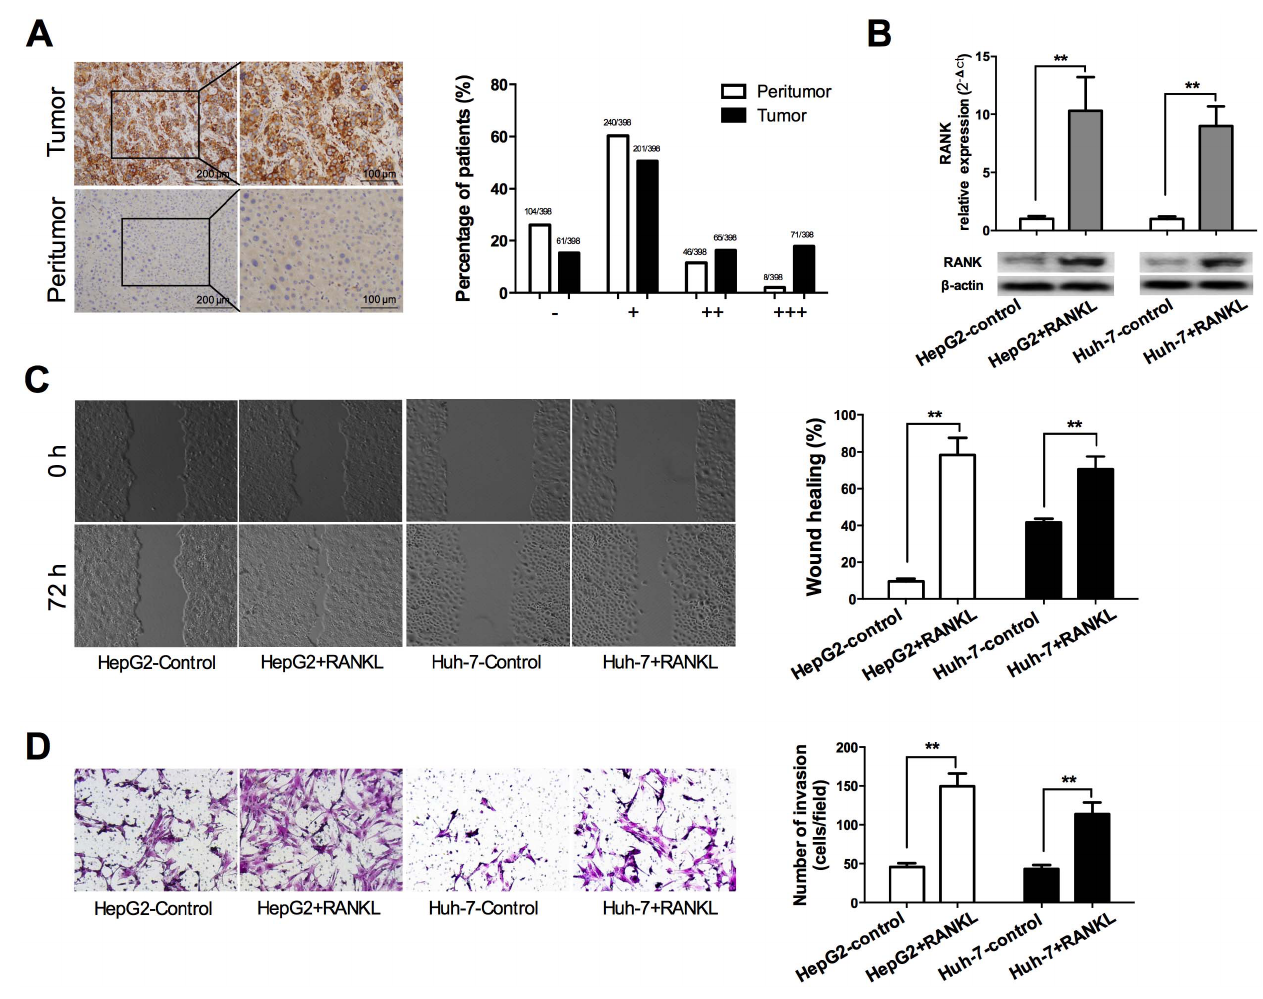
Figure 1. RANK was up-regulated in HCC and RANKL promoted migration and invasion of HCC cells. A. Left: Representative immunostaining images showed overexpression of RANK in HCC tumor tissues than paired peritumor tissues. Right: Bar graph showed the statistics of staining-intensity analysis in 398 HCC patients. RANK expression level in tumor tissues was significantly higher than that in peritumor tissues ( p , 0.001). B. HepG2 and Huh7 cells were incubated with 100 ng/ml RANKL or PBS as control for 24 h. qRT-PCR and Western blot analyses indicated that RANKL significantly promoted the expression of RANK. C. HepG2 and Huh7 cells were incubated with 100 ng/ml RANKL or PBS as control for 24 h. Wound healing assay demonstrated RANKL significantly promoted migration ability of the two cell lines (magnification 6 200). D. HepG2 and Huh7 cells were incubated with 100 ng/ml RANKL or PBS as control for 24 h. The number of HepG2 and Huh7 cells invading through the Transwell membrane increased significantly upon RANKL treatment (magnification 6 200). ** p , 0.01 compared with